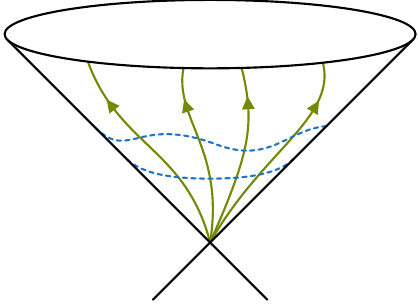
Figure 2: Carroll structure on the light cone of the embedding space